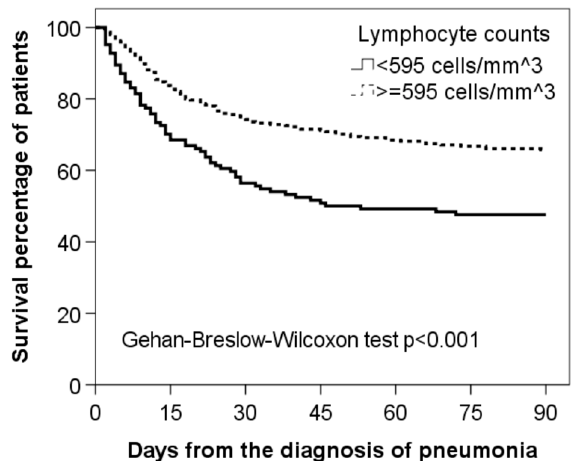
Figure 2. Kaplan–Meier survival curves for 90-day mortality in ICU-AP patients in relation to their lymphocyte counts at diagnosis.